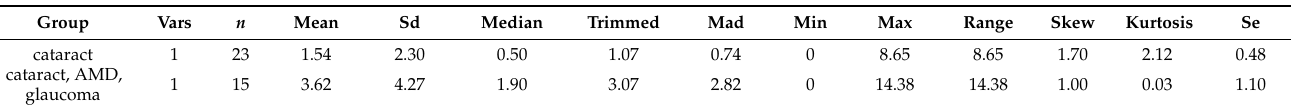
Figure 7. Statistical significance of differences in BPs’ content in AH for cataract and cataract with coexisting ocular pathologies (AMD, glaucoma).